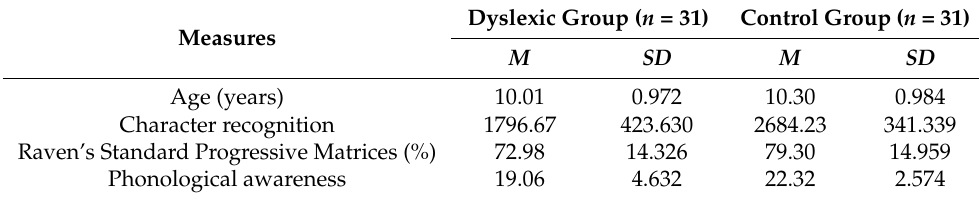
Table 1. Descriptive characteristics of Chinese dyslexic and control groups.